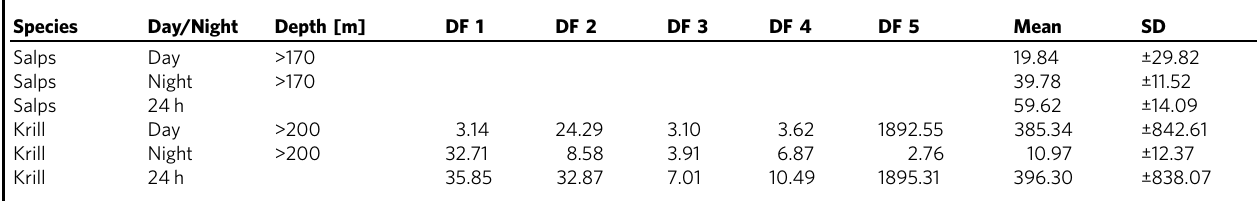
Table 5 Potential faecal pellet (FP) fl ux for krill and salps.